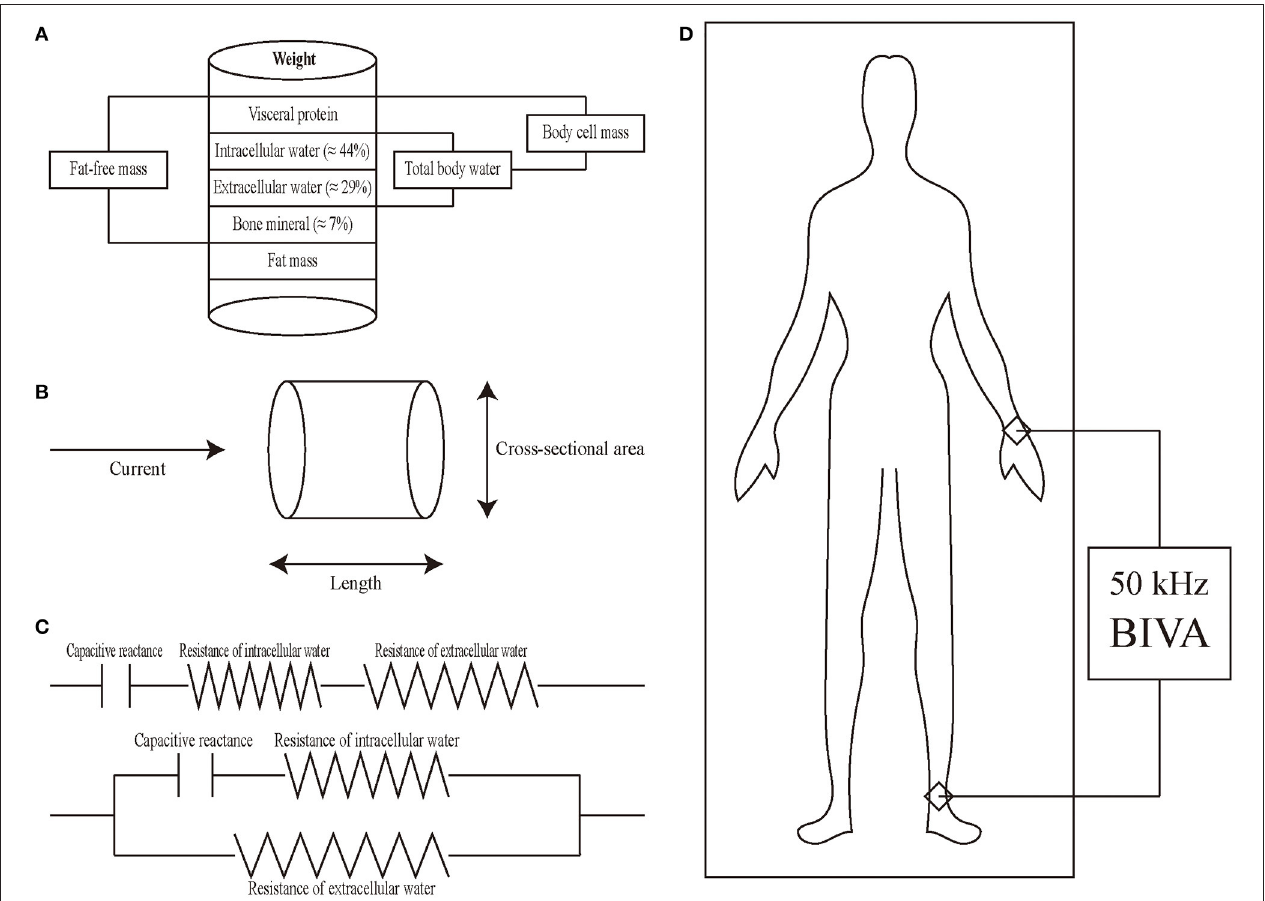
FIGURE 1 | Introduction of BIVA. (A) Schematic diagram of intracellular water, extracellular water, total body water, body cell mass, and fat-free mass. (B) Principles of BIVA from physical characteristics to body composition. Cylinder model for the relationship between impedance and geometry. The resistance of a length of homogeneous conductive material of uniform cross-sectional area is proportional to its length and inversely proportional to its cross-sectional area. (C) The human body consists of resistance and capacitive reactance connected in series (upper) or in parallel (lower). (D) Placement of electrodes in BIVA and total body water is measured by the ankle-wrist bioimpedance